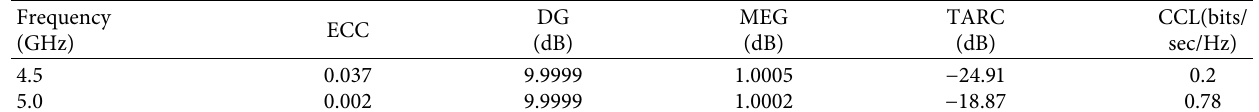
Figure 11: Simulated and measured DG. Table 2: Antenna diversity parameters.